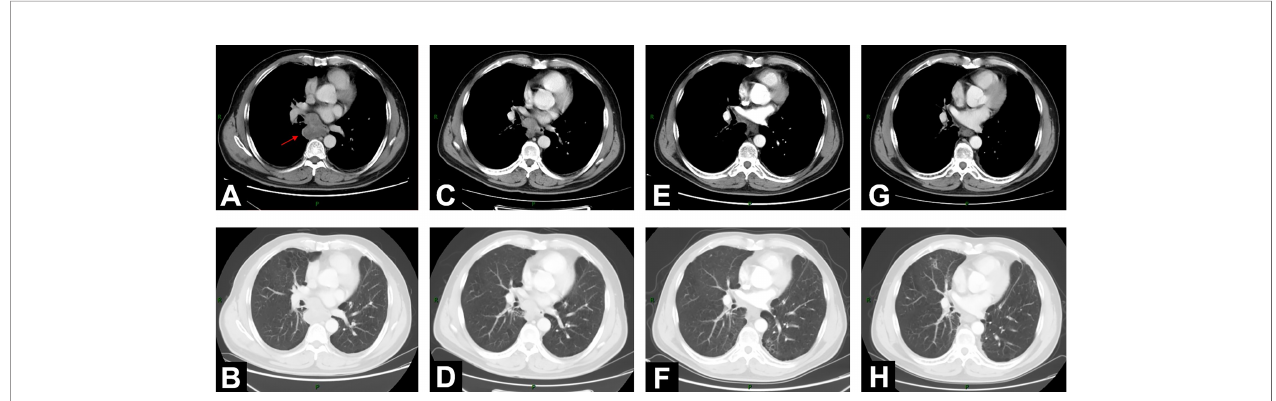
FIGURE 1 | Changes of mediastinal lesion on chest contrast-enhanced CT scans. (A, B) On June 18, 2020, CT demonstrated enlarged mediastinal lymph node station 7 with heterogeneous enhancement (5.2 cm * 4.7 cm). (C, D) CT on August 11, 2020, after 2-cycle induction chemotherapy (3.9 cm * 2.9 cm). (E, F) CT